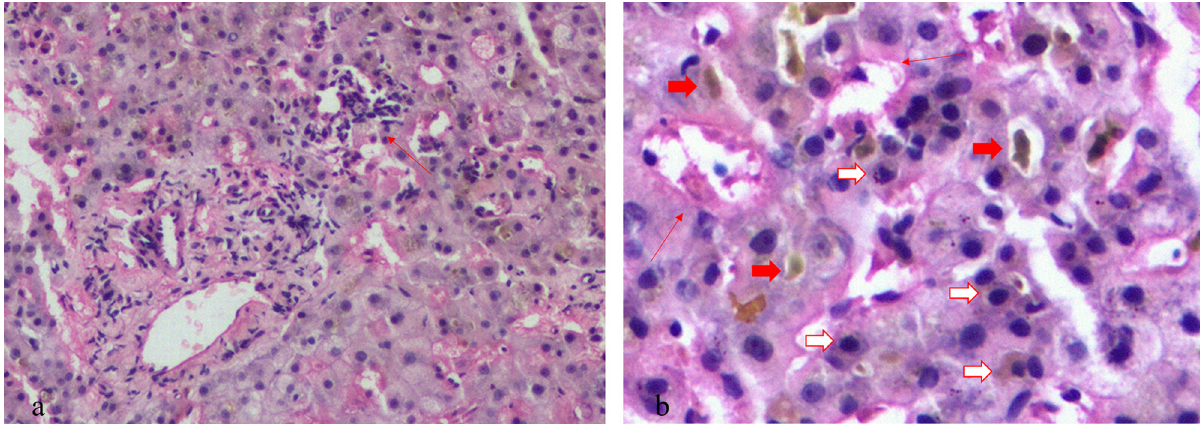
Figure 3: Pathological changes in a liver puncture. ( a ) Histological features of the liver were mainly lobular in fl ammation ( arrow ) , with ductopenia, cholestasis of the capillary bile duct, and no obvious liver fi brosis ( 100, hematoxylin - eosin staining ) . ( b ) Panlobular hepatitis with lymphoplasmacytic in fi ltration ( white arrow ) , hemorrhage of sinus endothelium ( arrow ) , and cholestasis of capillary bile duct ( red arrow ) ( 200, hematoxylin - eosin staining )